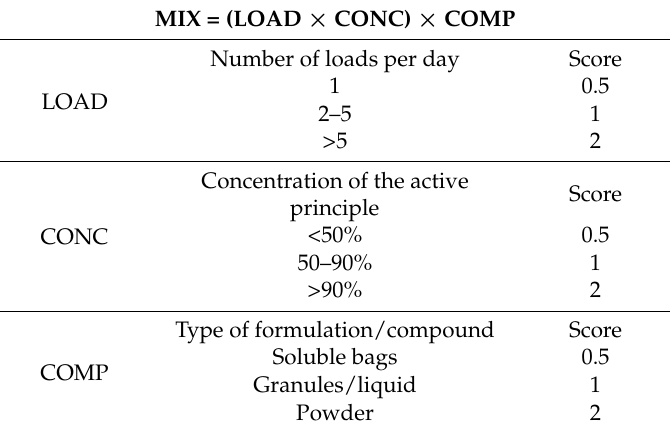
Table 3. Exposure factors during mixing and loading activities.